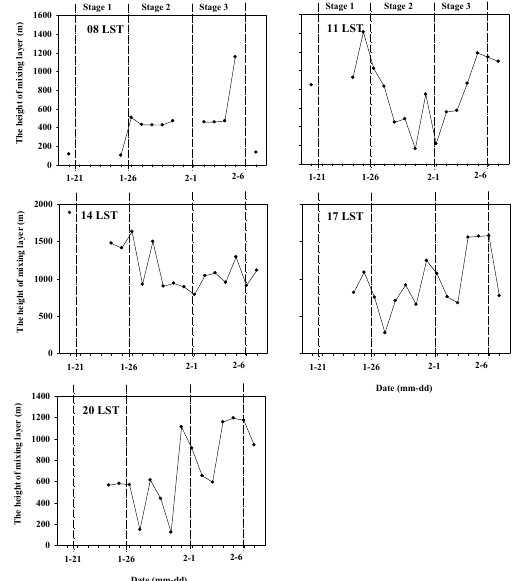
Figure 5. The height of the mixing layer (m) in Chengdu among different haze stages at a time interval of 3 h.